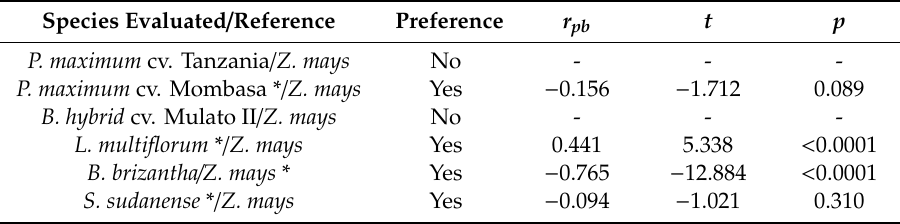
Table 2. Trichome density influence on oviposition preference of S. frugiperda . Species Evaluated /